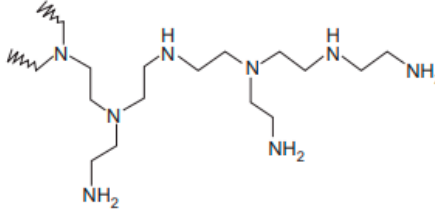
Figure 1. Chemical structure of Lupasol.